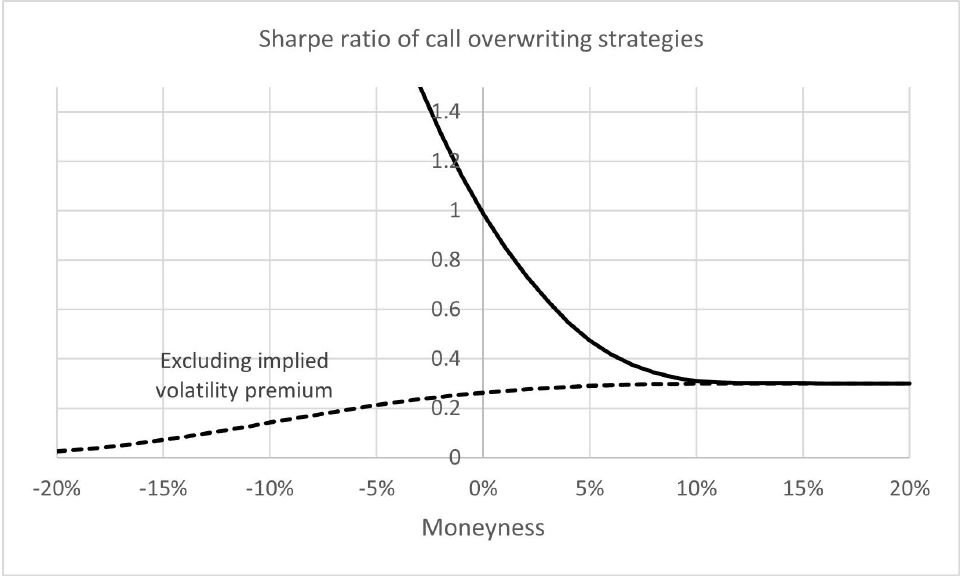
Figure 6. The Sharpe ratio for an underlying asset with an overlaid call overwriting strategy for a range of strike prices. The dotted line assumes the implied volatility is equal to the underlying asset volatility. The solid line includes the implied volatility premium in the price of the